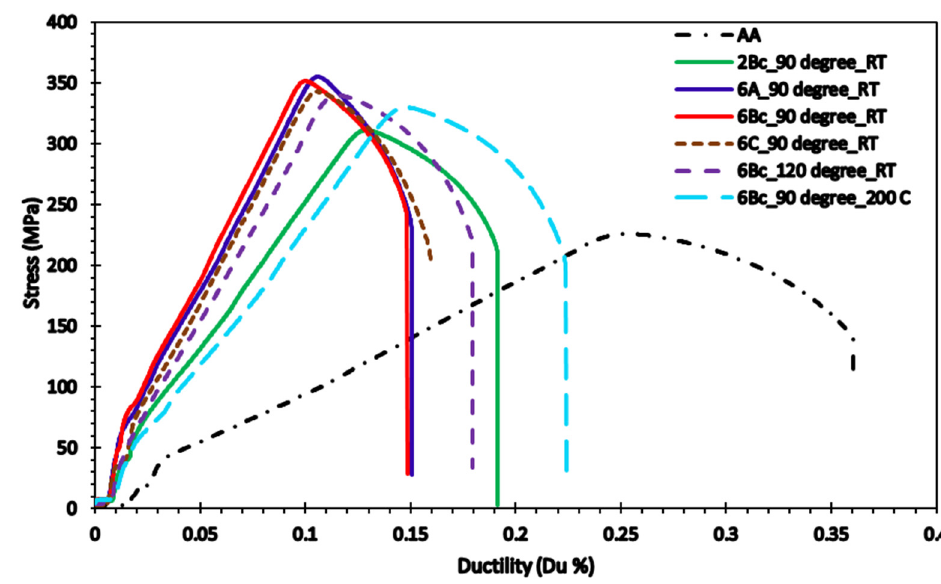
Figure 9. Stress-strain curves of Cu billets before and after ECAP processing.